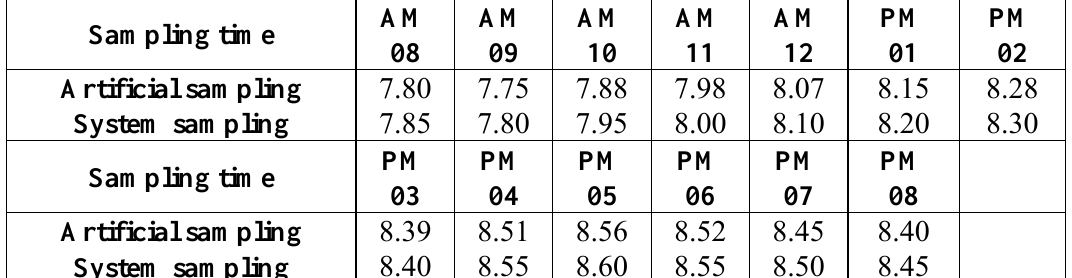
Table 2. Comparing the pH from artificial sampling and the monitoring